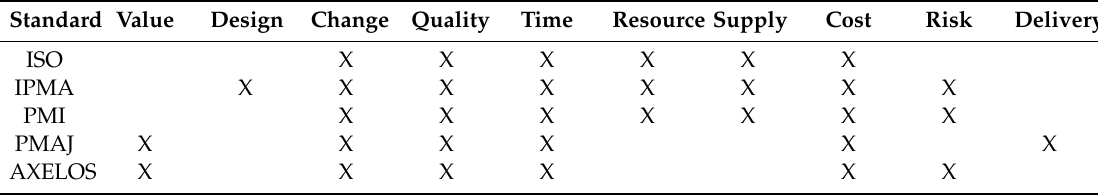
Table 1. Management areas dependent on the